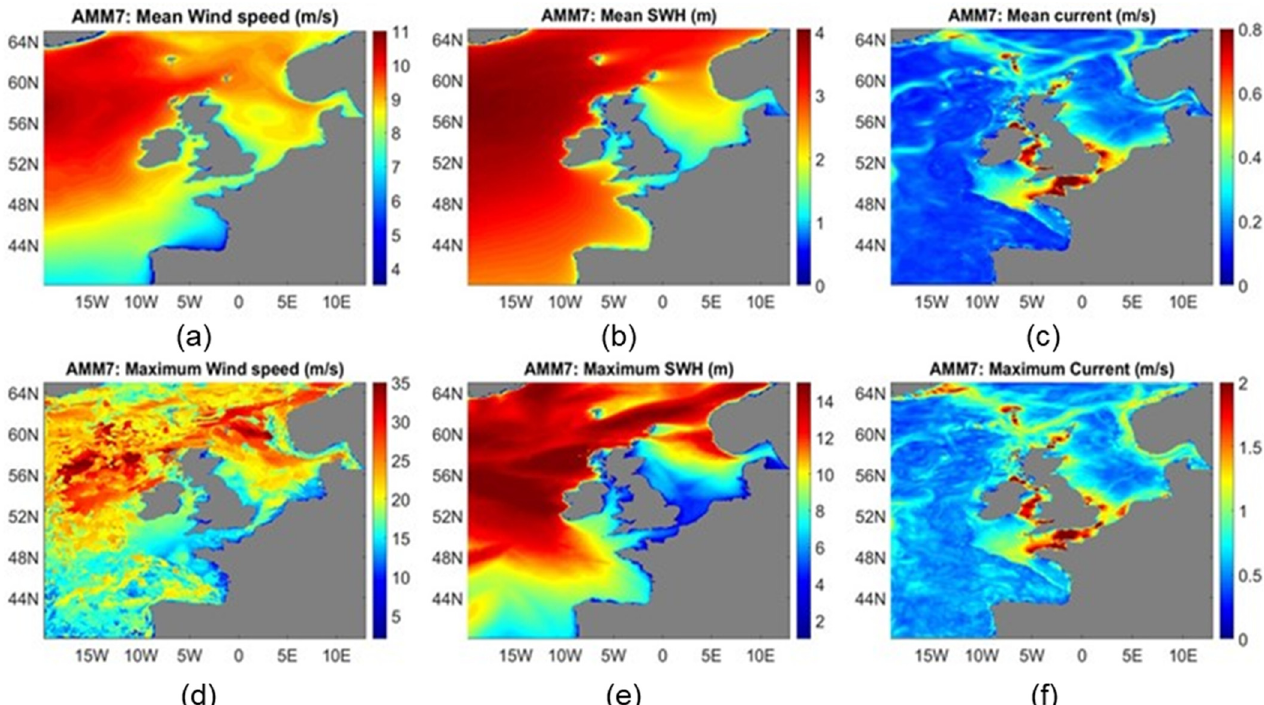
Figure 2. Spatial maps of temporal mean ( a – c ) and maximum ( d – f ) over period July 2014 to June 2016 of wind speed (m/s) ( a , d ), Significant Wave Height (m) ( b , e ), Current velocity (m/s) ( c , f ) from Met Office FOAM and WaveWatch III on the AMM7 grid.